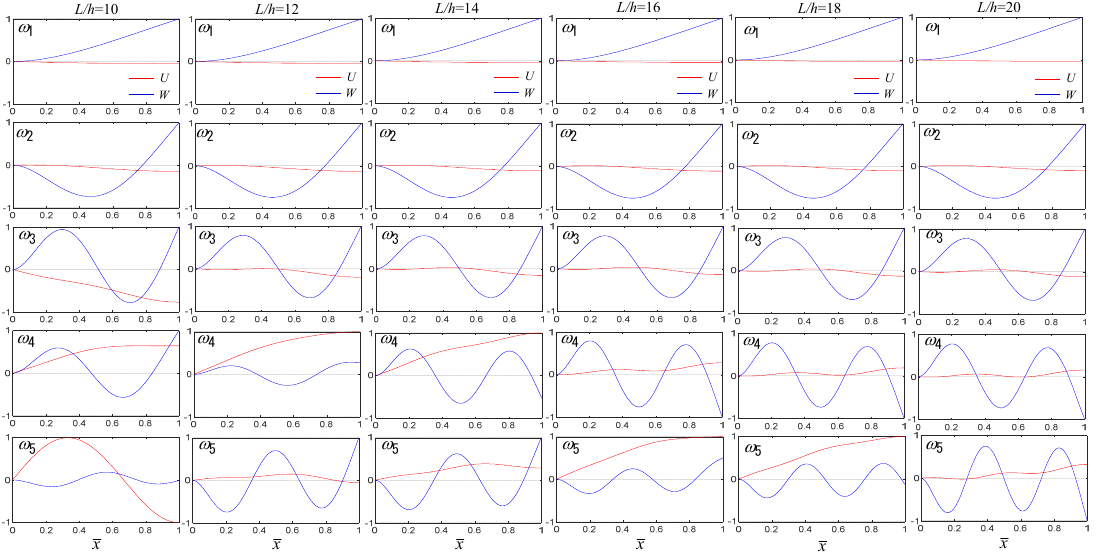
Figure 8. Variation in the first five mode shapes of soft-core three-layered beams with the cantilevered end condition with respect to the variation of L/h.